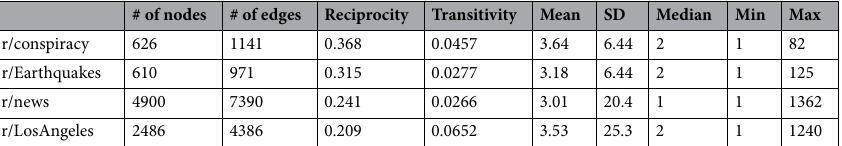
Table 3. Conversation network measures in different subreddits. Reciprocity is the likelihood of mutual connections. Transitivity is the probability that the adjacent nodes of a node are connected. The columns Mean, SD, Median, Min, Max are calculated for degrees. Note that reciprocity and transitivity calculations are based on the whole graph instead of each node so standard deviations cannot be derived as degrees.